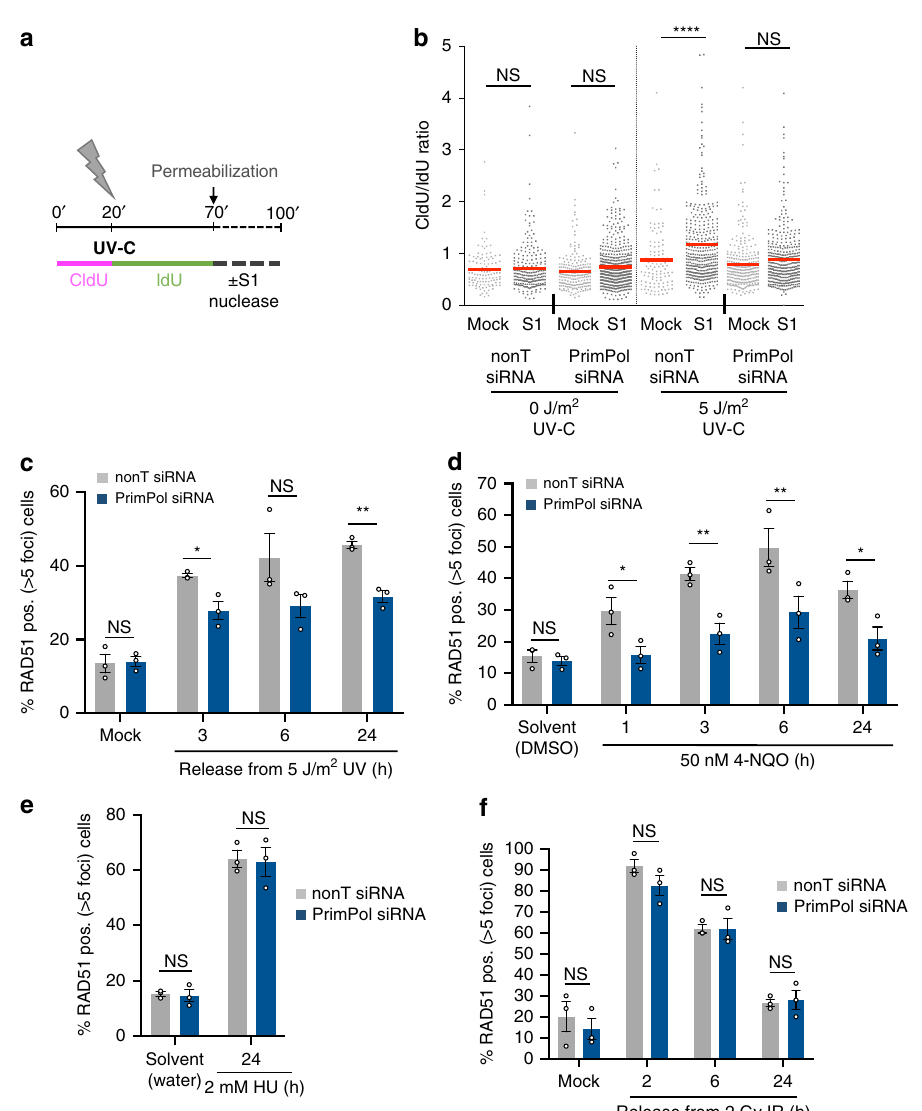
Fig. 5 PrimPol promotes RAD51 foci formation speci fi cally in response to bulky adducts. a Strategy for the S1-modi fi ed DNA fi ber assay with ultraviolet (UV-C) irradiation. b CldU/IdU ratios after S1-modi fi ed DNA fi ber assay in cells treated with 5 J/m 2 UV-C or mock-treated as in ( a ), in the presence of nonT or PrimPol siRNA. Lines represent mean. Data from 4 repeats. c Percentages of cells with >5 RAD51 foci after release from 5 J/m 2 UV, in presence of nonT or PrimPol siRNA. Release from mock-irradiation was 3 h. n = 3. d Percentages of cells with >5 RAD51 foci after treatment with 50 nM 4-nitroquinolie 1-oxide (4-NQO), in presence of nonT or PrimPol siRNA. The release from DMSO was 1 h. n = 3. e Percentages of cells with >5 RAD51 foci after treatment with 2 mM hydroxyurea (HU) for 24 h, in presence of nonT or PrimPol siRNA. n = 3. f Percentages of EdU positive cells with >10 RAD51 foci after release from 2 Gy ionizing radiation (IR), in the presence of nonT or PrimPol siRNA. Release from mock-irradiation was 2 h. n = 3. Source data are provided as a Source Data fi le. The means and SEM (bars) of at least three independent experiments are shown. Asterisks indicate p-values (One-way ANOVA for B; one-sided student ’ s t -test for C-F, * p < 0.05, ** p < 0.01, *** p < 0.001, **** p <